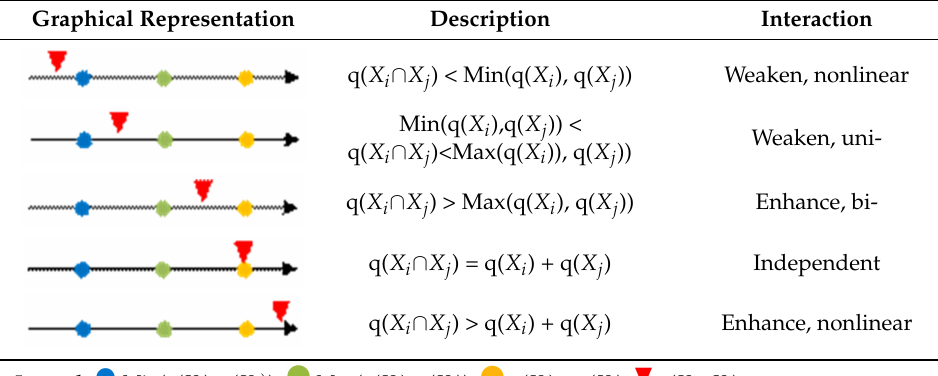
Table 2. Interaction between explanatory